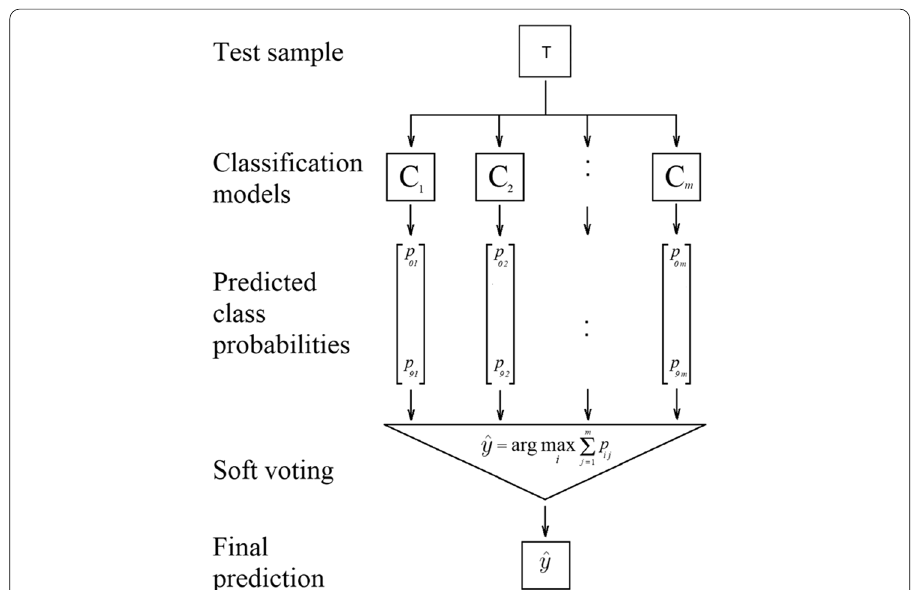
Fig. 5 Voting Algorithm